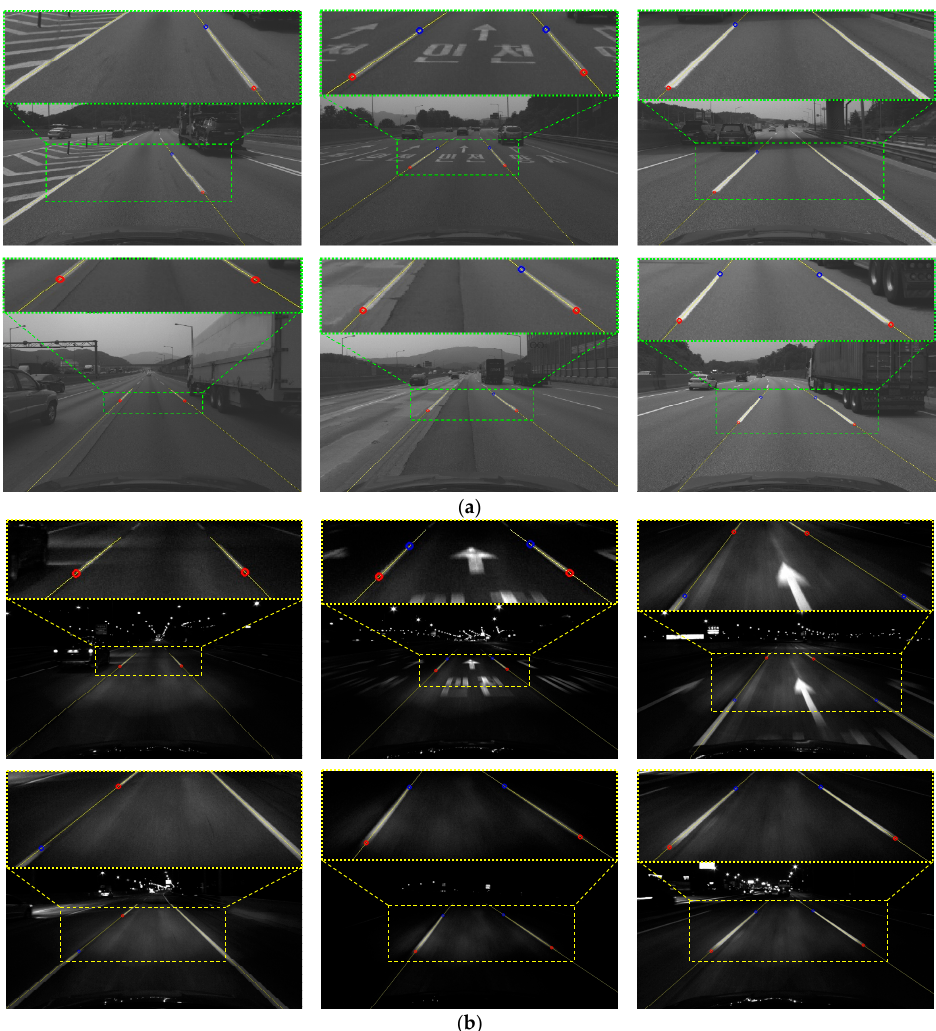
Figure 13. Lane endpoint detection results of the proposed method in ( a ) daytime and ( b ) nighttime. Table 7. Performance of the method [31] in daytime.